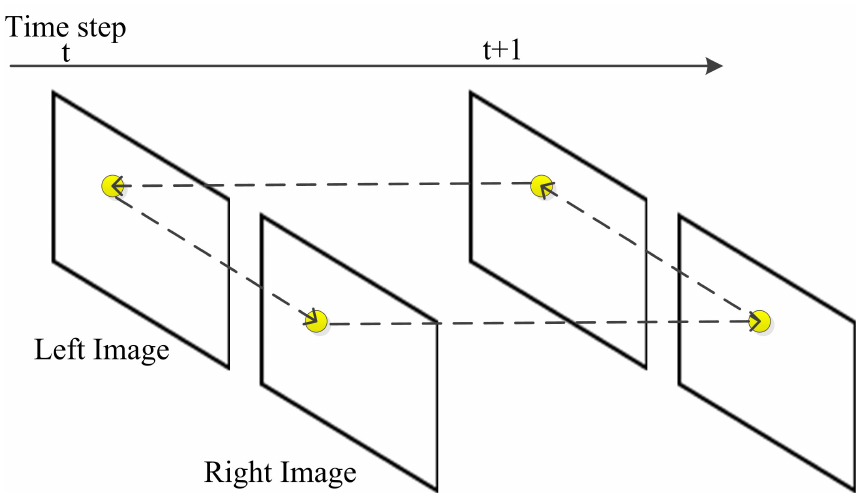
Figure 3. Circle matching. Matching the features from time t in the left image, the right image next, then time t + 1 in the right image, and finally the left image. A feature is selected when it is matched in all four